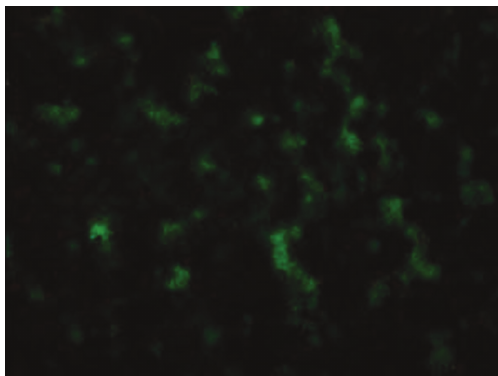
Figure 1: Screening of positive clone of TPG strain (attenuated S. typhimurium containing pcDNA4-GFP plasmid). The green fluorescence of the positive clone was observed under a fluorescence microscope ( ×